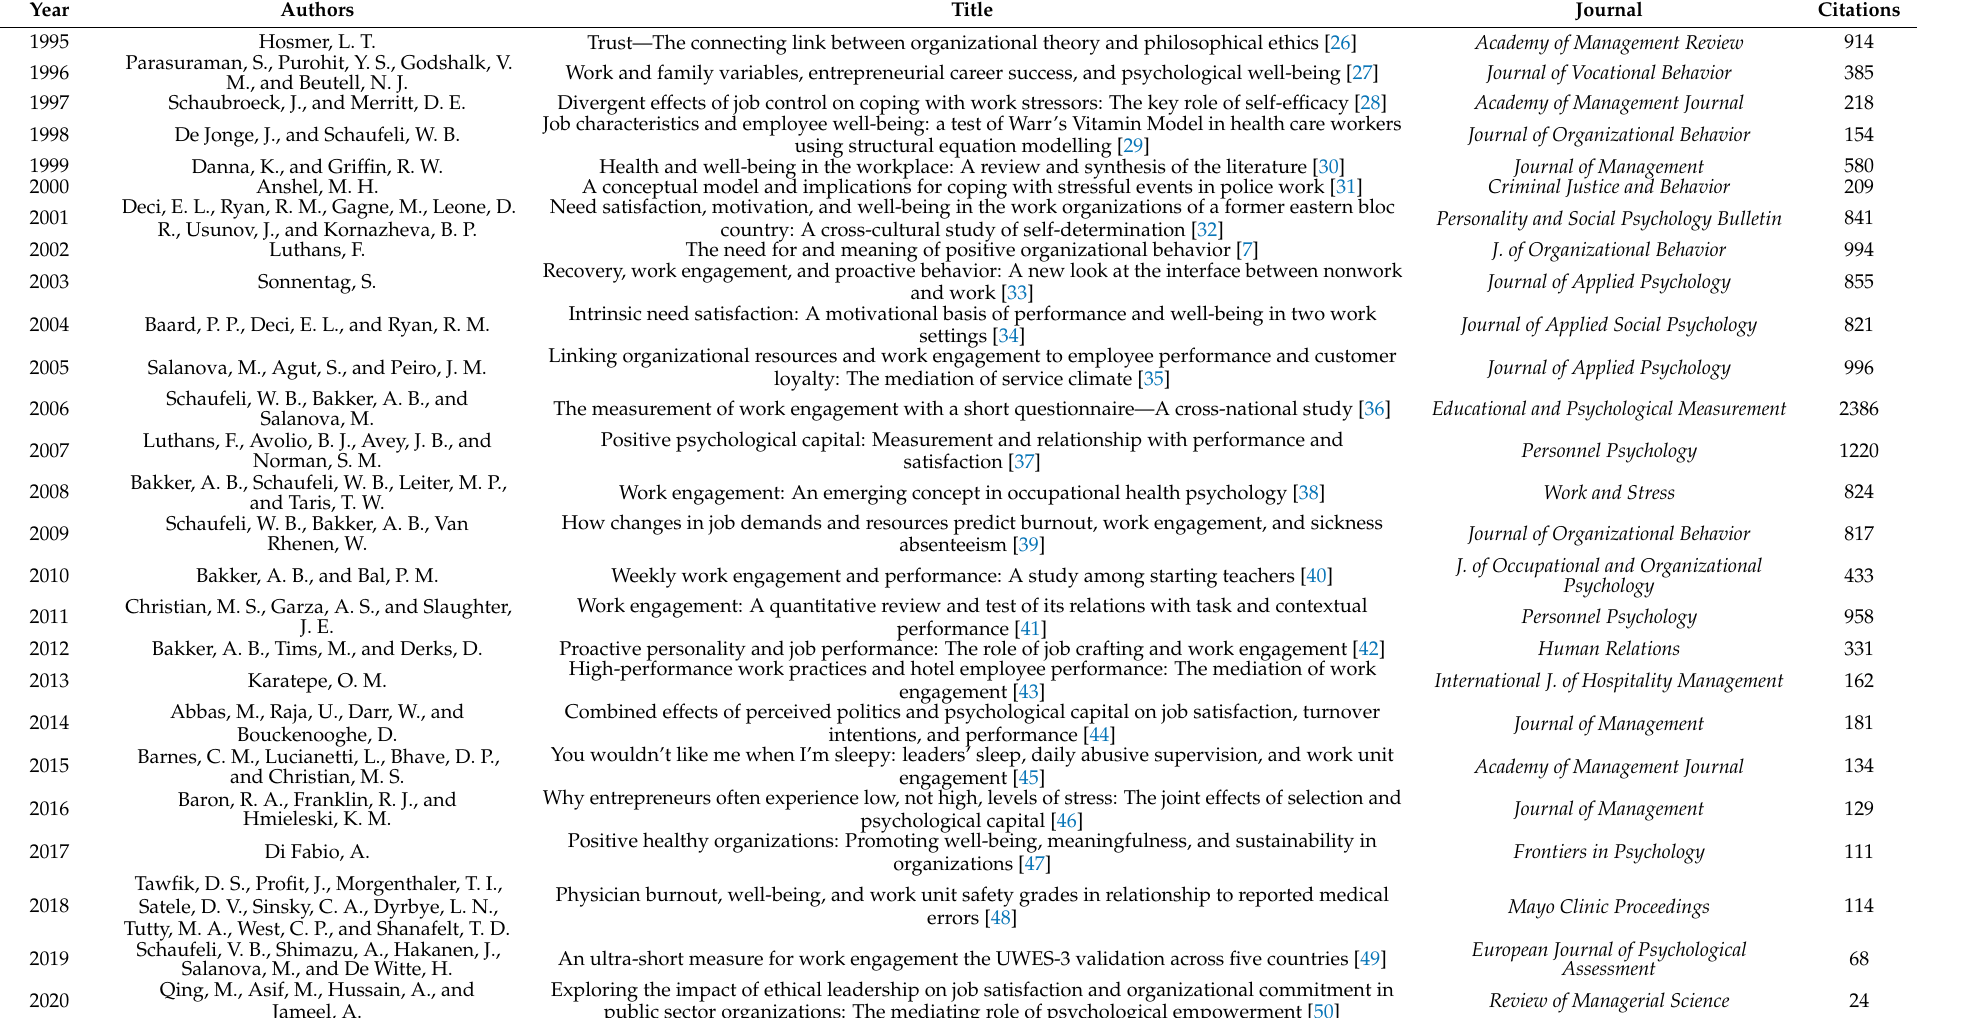
Table 3. Top cited papers between 1995 and